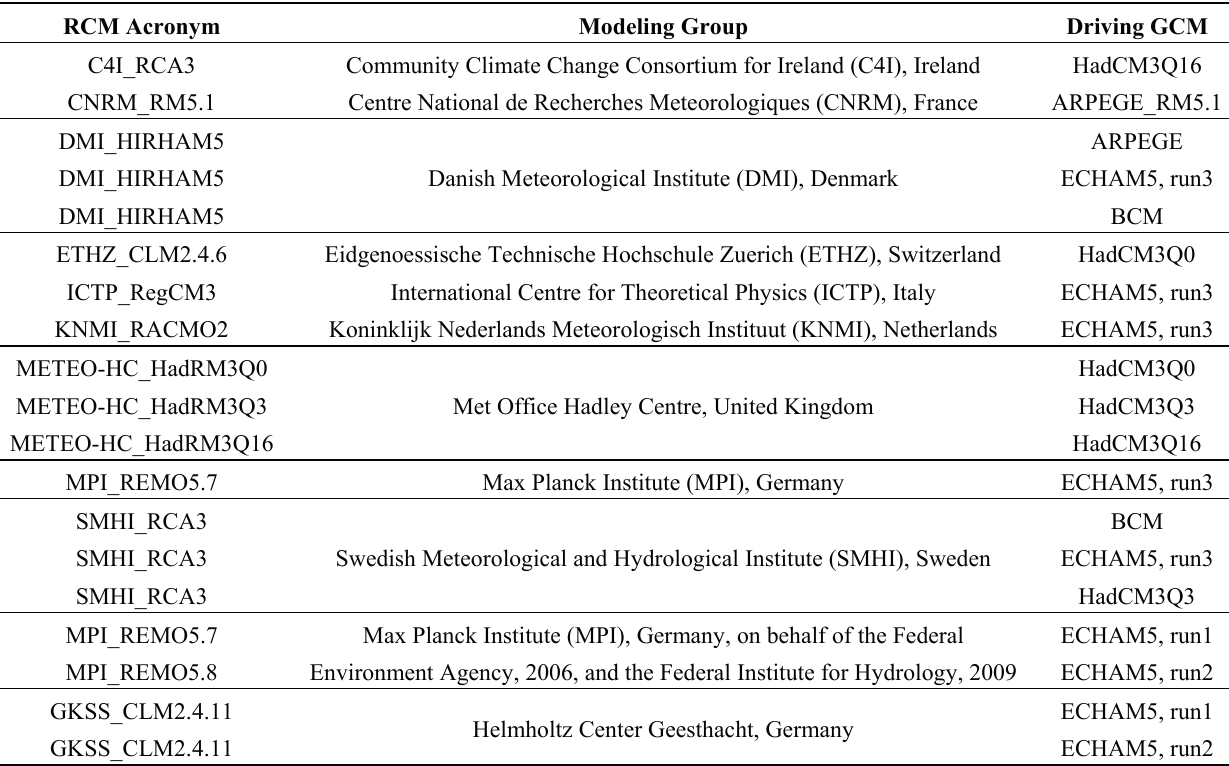
Table 1. Regional climate models used for future temperature